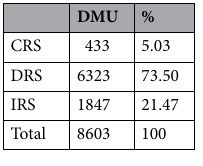
Table 2. Distribution of returns to scale.